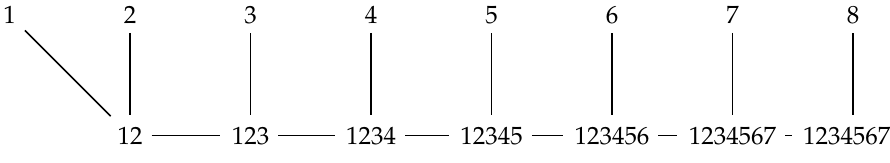
Figure 1. Order of merges under the basic branch-and-bound